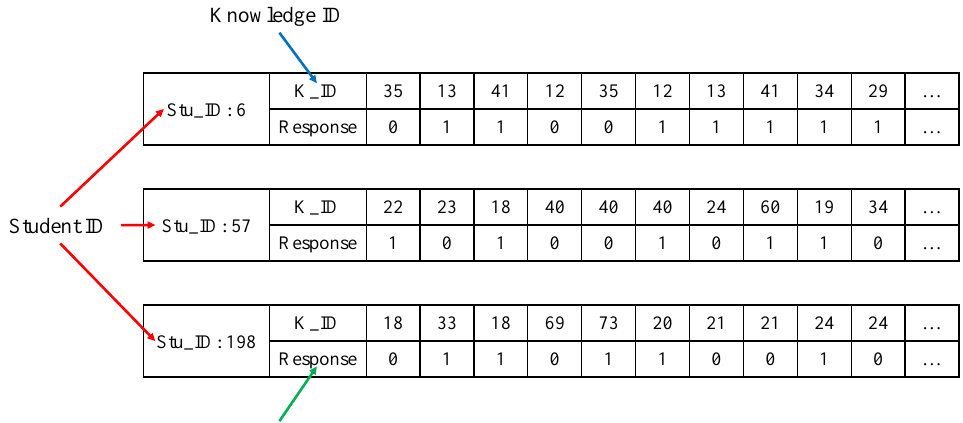
Figure 2. Description of a portion of the dataset.